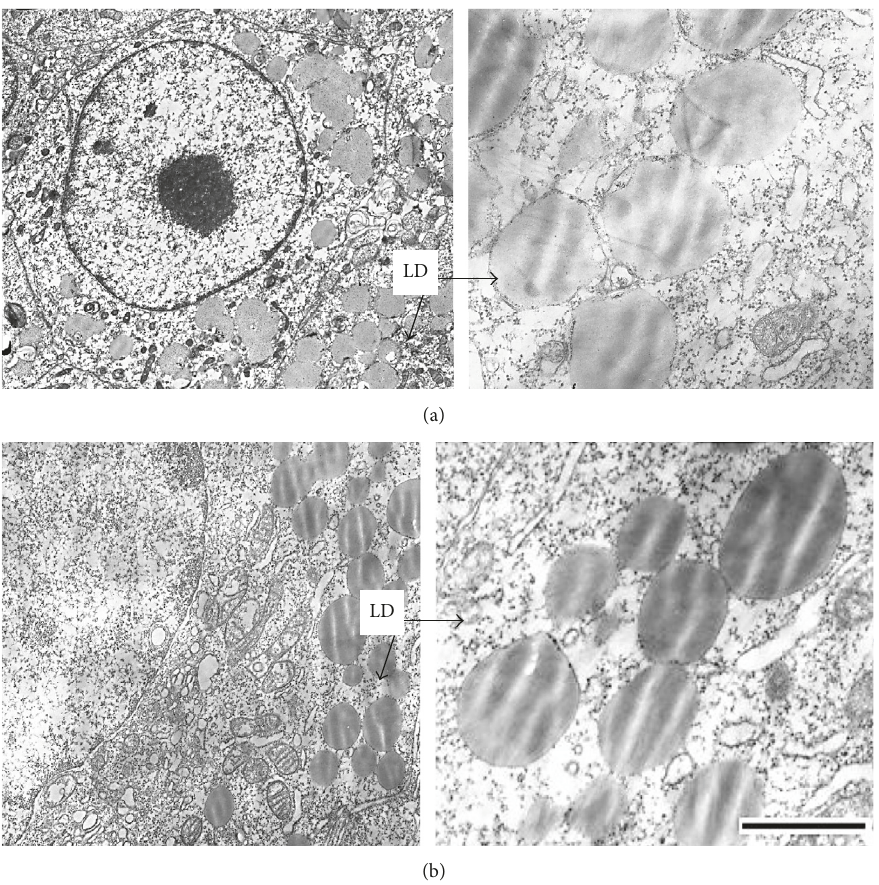
Figure 2: Lipid droplets in cytoplasm of B10.MLM cells. Multiple lipid droplet (LD) particles of moderate electron density in cytoplasm after incubation with oil-formulated (a) and microencapsulated (b) lycopene for 42 hours. Scale bar 1 𝜇